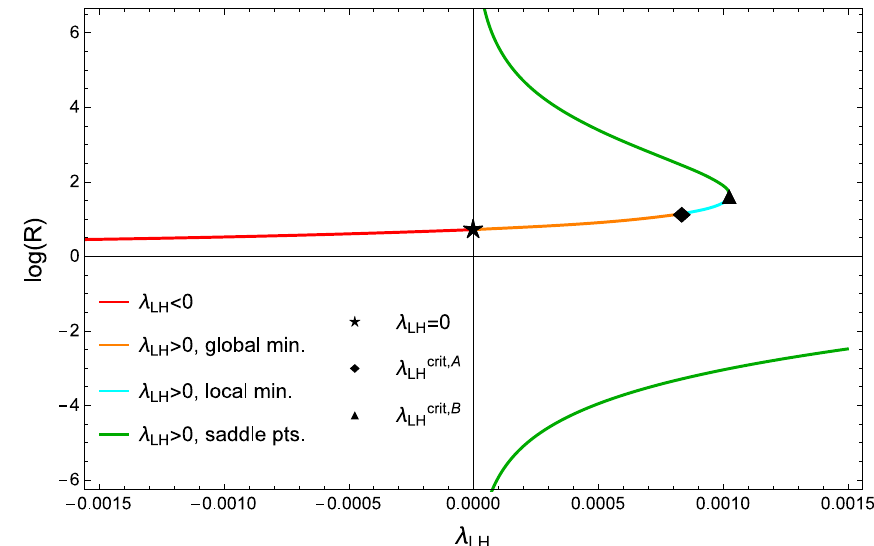
Fig. 5 Hierarchy R regimes depending on the value of λ LH . For the initial case { λ LH = 0 ,λ L = 0 . 001 , g L = 0 . 6 ,λ H = − 0 . 001 , g H = 0 . 6 } we have a hierarchy depicted by (cid:14) . For λ LH < 0 the hierarchy decreases slowly, as represented by the red line. On the other hand, for λ LH > 0 it increases as shown by the orange line for the case of the central minimum being the global one up to λ crit , A